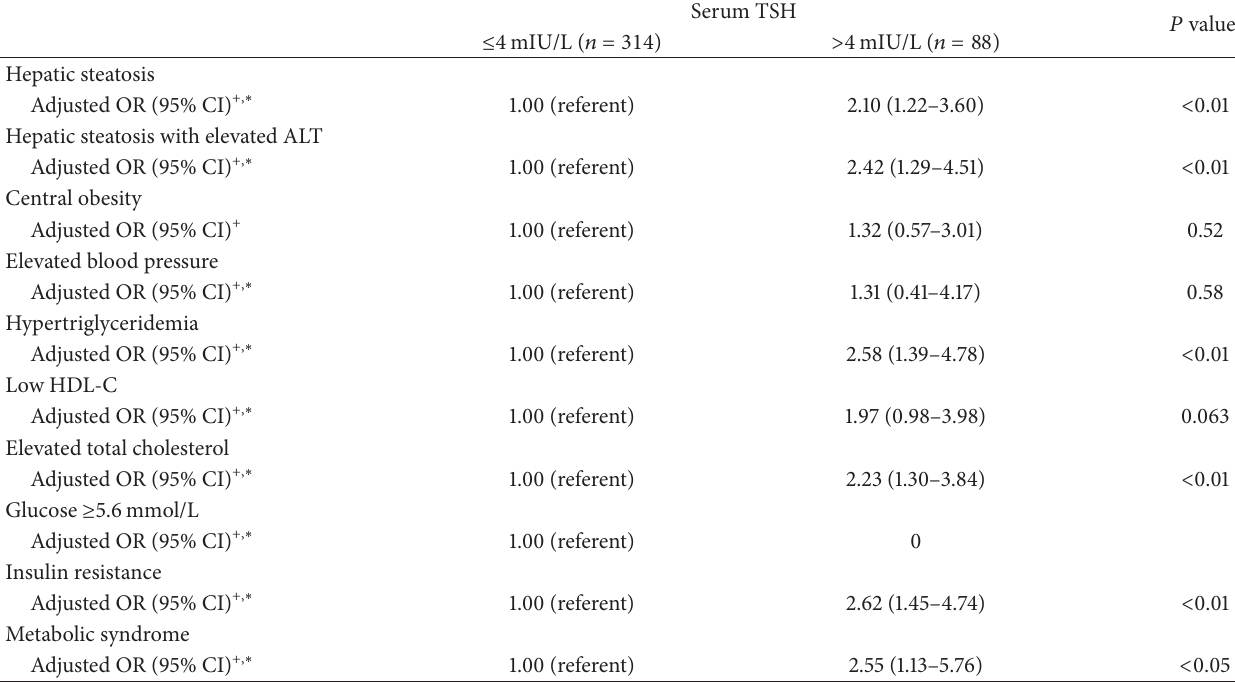
Table 3: Adjusted odds ratios (and 95% CIs) of hepatic steatosis, hepatic steatosis with elevated ALT, metabolic syndrome, and its components among 402 overweight/obese children.